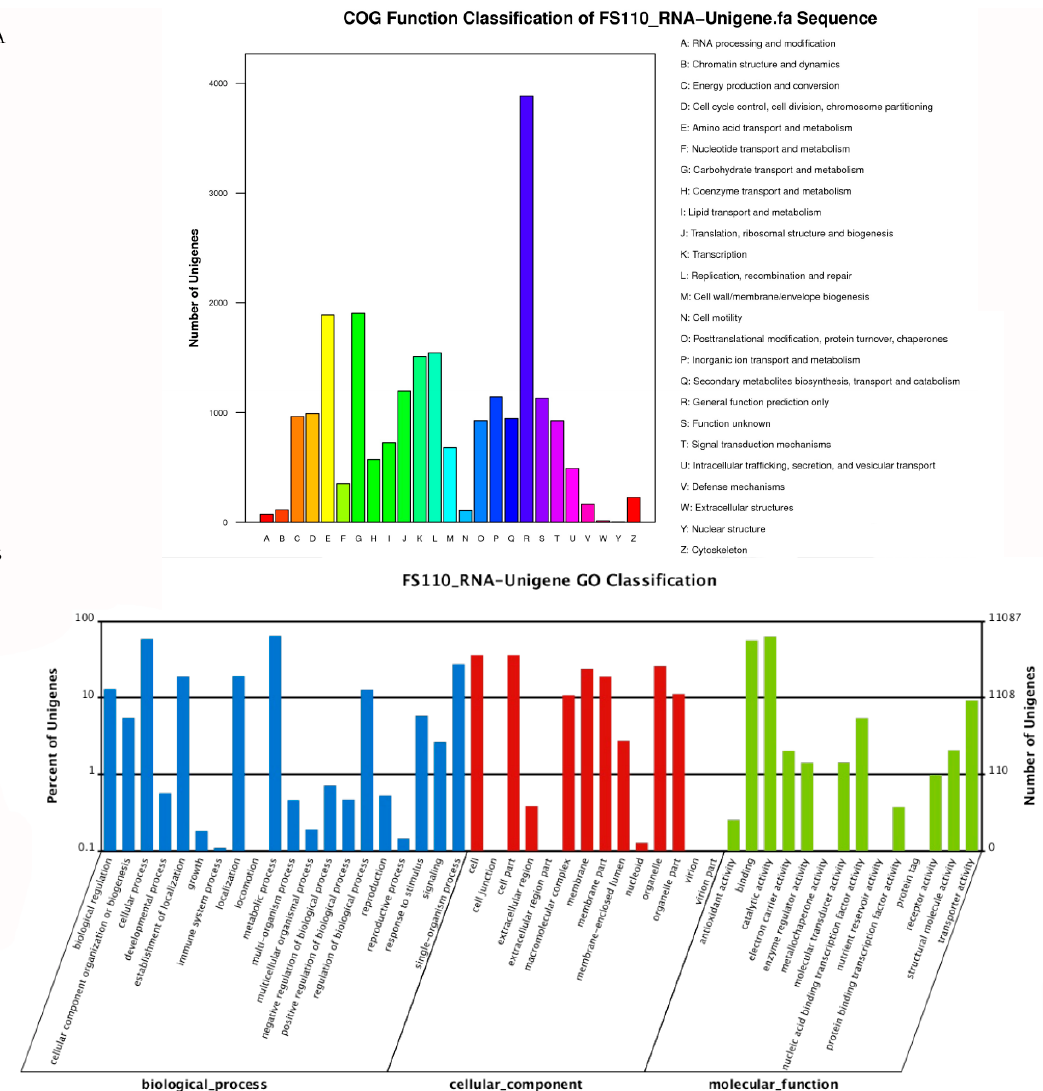
Figure 2. COG (Cluster of Orthologous Groups of proteins) function and GO (Gene Ontology Consortium) function classification of the D. cejpii FS110 transcriptome: ( A ) COG functional classification of the D. cejpii FS110 transcriptome; ( B ) GO functional classification of the D. cejpii FS110 transcriptome.